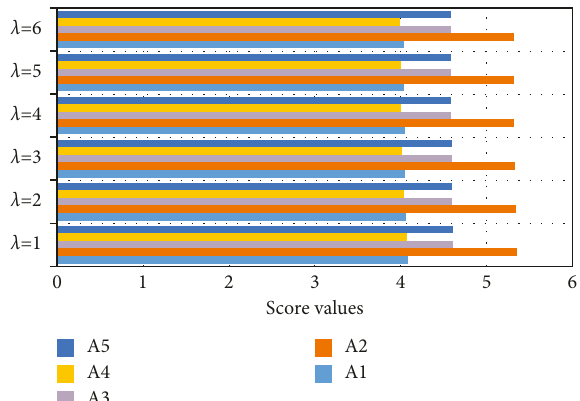
Figure 4: Score values for thermal power stations A